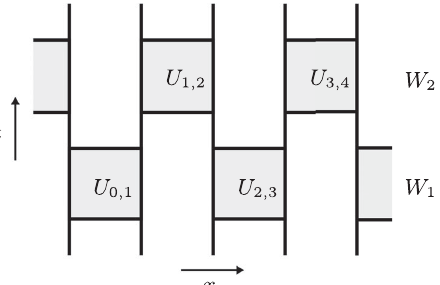
FIG. 1. Diagram of the Floquet operator of a brickwork model with periodic boundary conditions, with time running verti- cally. The vertical lines mark positions of sites, and the Floquet operator is W ¼ W 2 W 1 . W 1 and W 2 are tensor products of two-site unitary gates U x;x þ 1 , where U x;x þ 1 couples the sites ð x; x þ 1 Þ